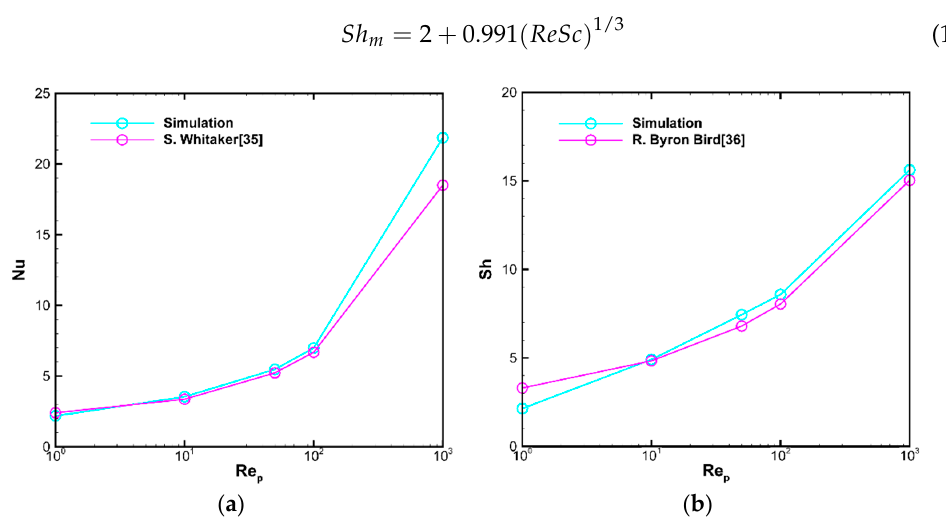
Figure 2. Validation of a single particle: ( a ) Nusselt number vs. Reynolds number and ( b ) Sherwood number vs. Reynolds number.